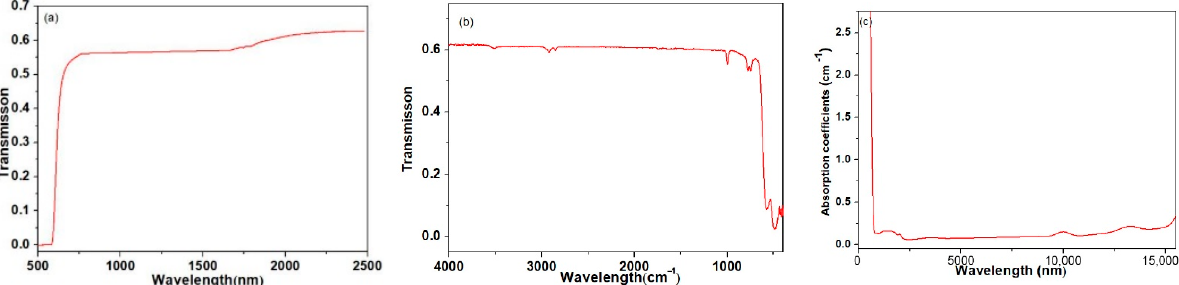
Figure 4. Transparency spectrum of AGGSe crystal (6 mm thick) ( a ) in the range of 500–2500 nm, ( b ) 4000–450 cm − 1 , and ( c ) the optical absorption spectra in the 950–15,500 nm by calculation.